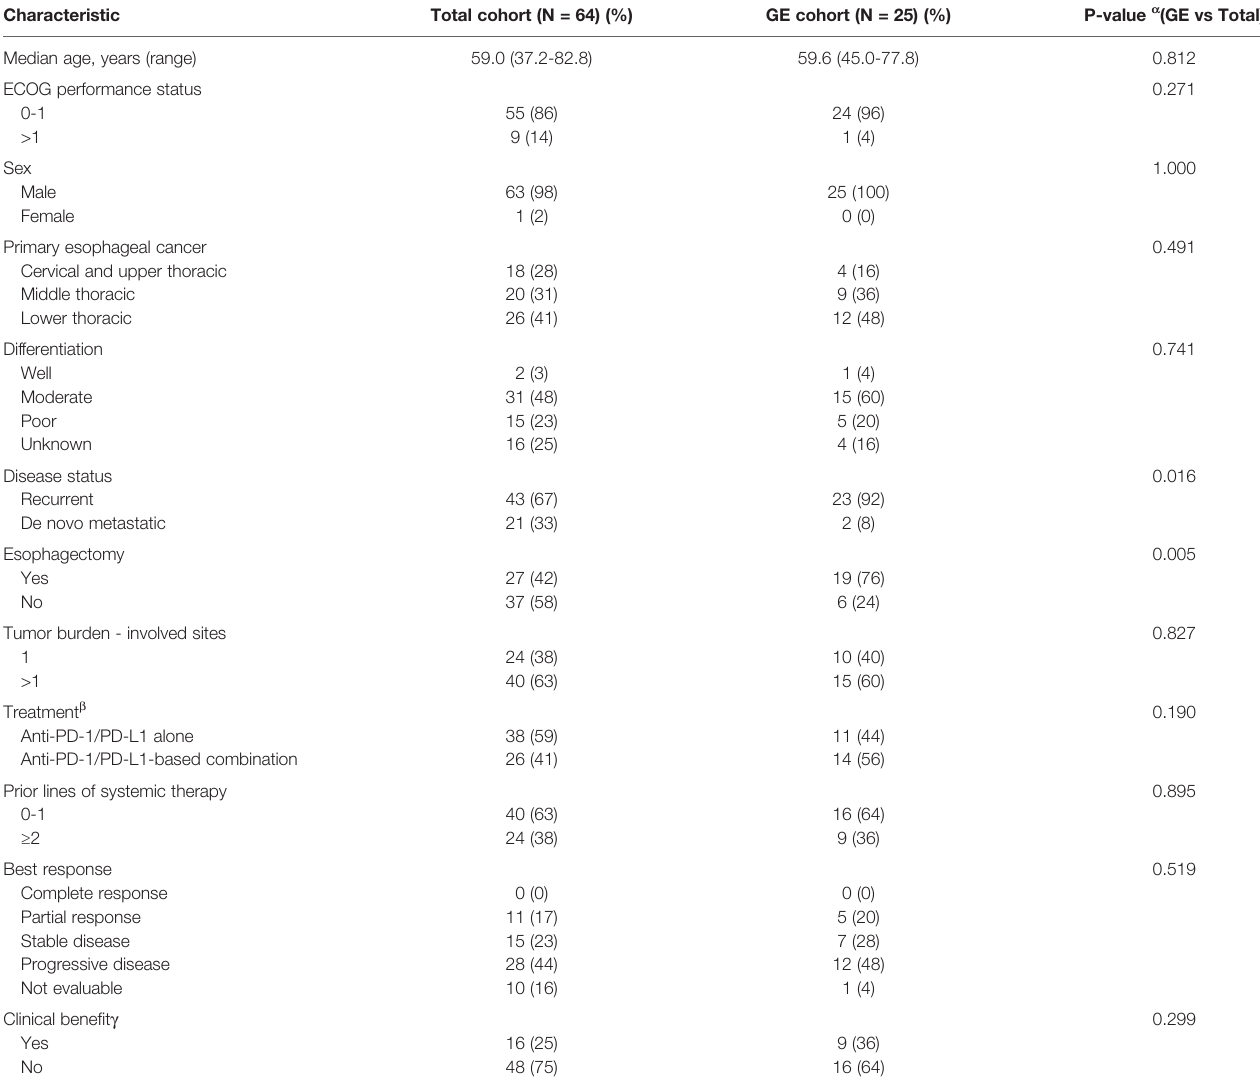
TABLE 1 | Baseline characteristics and response to